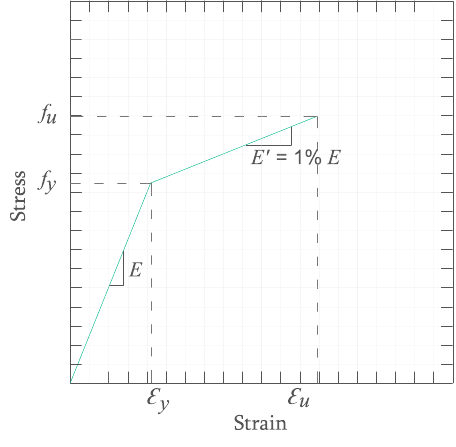
Figure 2. Idealised stress–strain curve for the